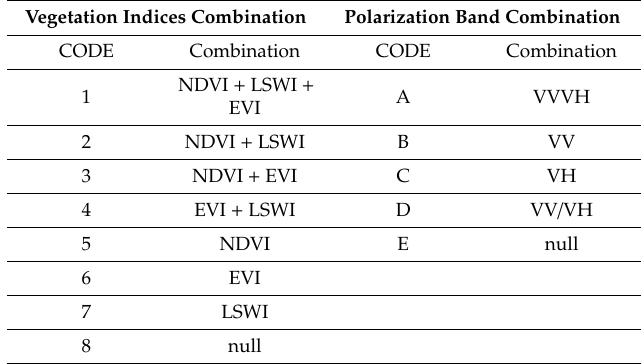
Table 3. Combination of the dataset used in this study.